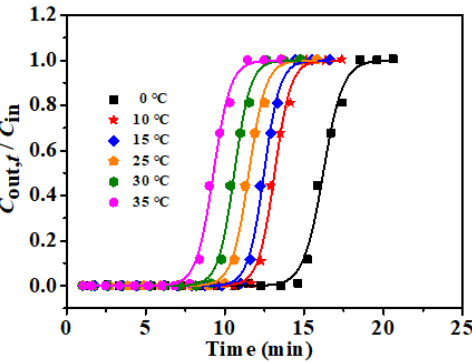
Figure 9. Adsorption breakthrough curves for rGOA-1 at different temperature by Yoon–Nelson model. Table 3. Influence of the temperature on the adsorption of L2 over rGOA-1 a . Temp. ( ◦